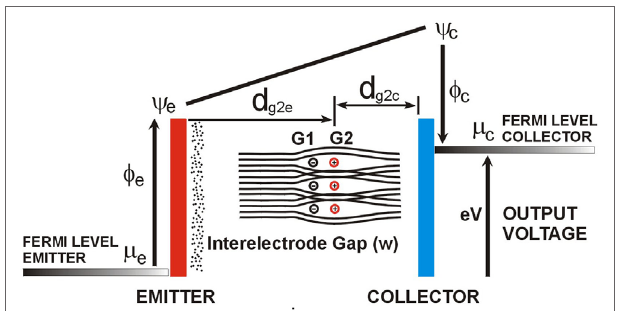
FigUre 1 | Concept diagram of the dual-grid thermionic energy convertor, grid 2 (G2) is the attractor and grid 1 (G1) is the deflector, the grids work in conjunction to attain electron transport and space charge mitigation with minimal power loss to G2, the device geometry and voltages/signals are important to attain efficient